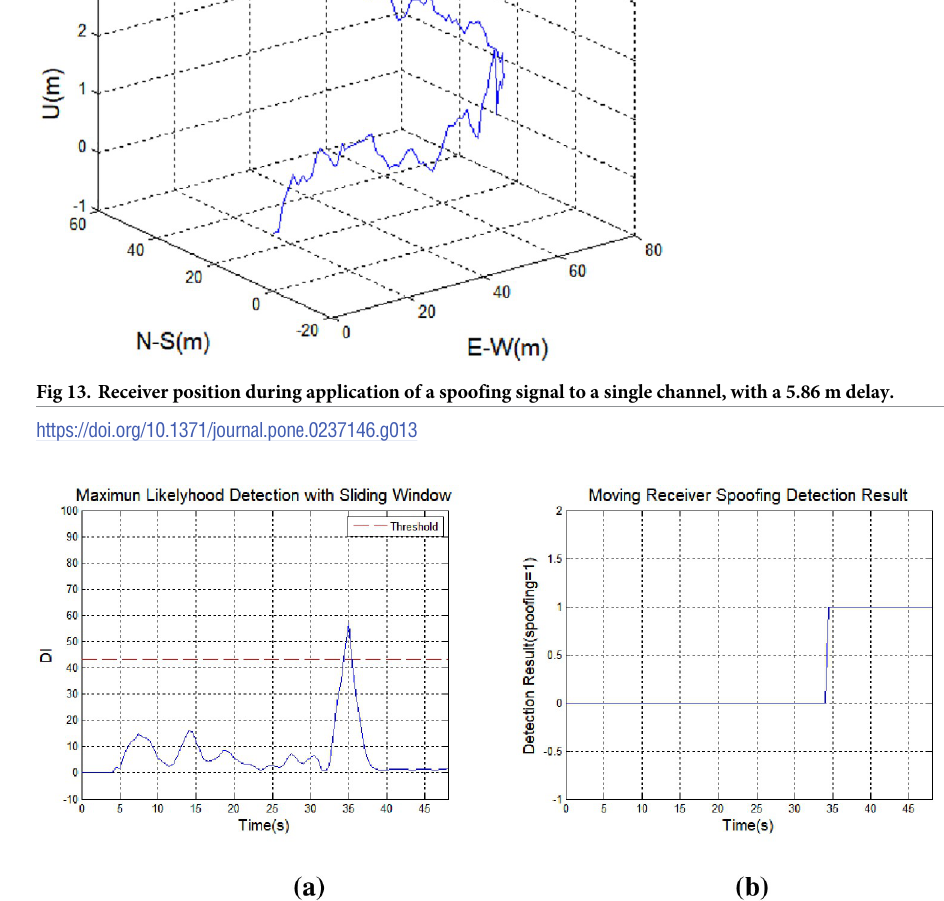
PLOS ONE | https://doi.org/10.1371/journal.pone.0237146 August 28,